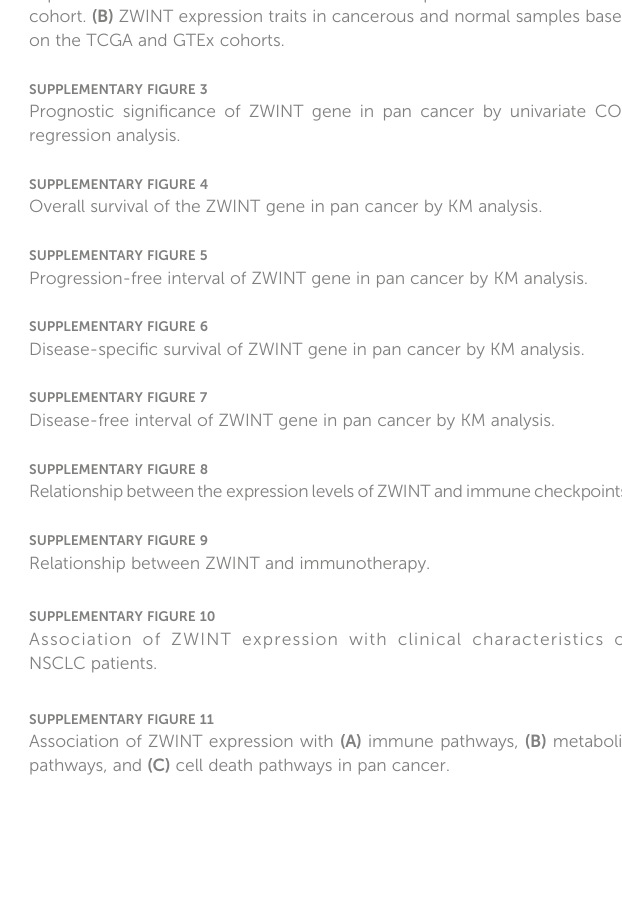
SUPPLEMENTARY FIGURE 11 Association of ZWINT expression with (A) immune pathways, (B) metabolic pathways, and (C) cell death pathways in pan